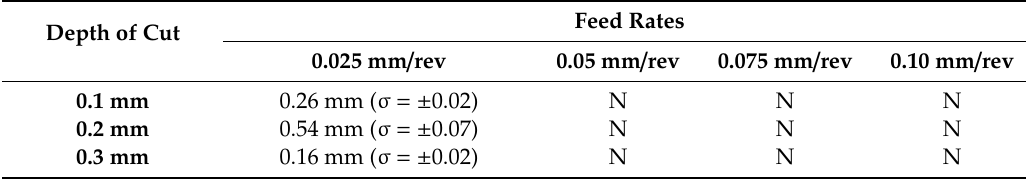
Figure 8. Burr formation plots across tools: ( a ) Uncoated Tool, ( b ) TiN-coated Tool, ( c ) TiAlN-coated Figure8. Burrformationplotsacrosstools: ( a )UncoatedTool, ( b )TiN-coatedTool, ( c )TiAlN-coatedTool. Tool. Table 5. Burr heights for uncoated tool samples. Table 5. Burr heights for uncoated tool samples.